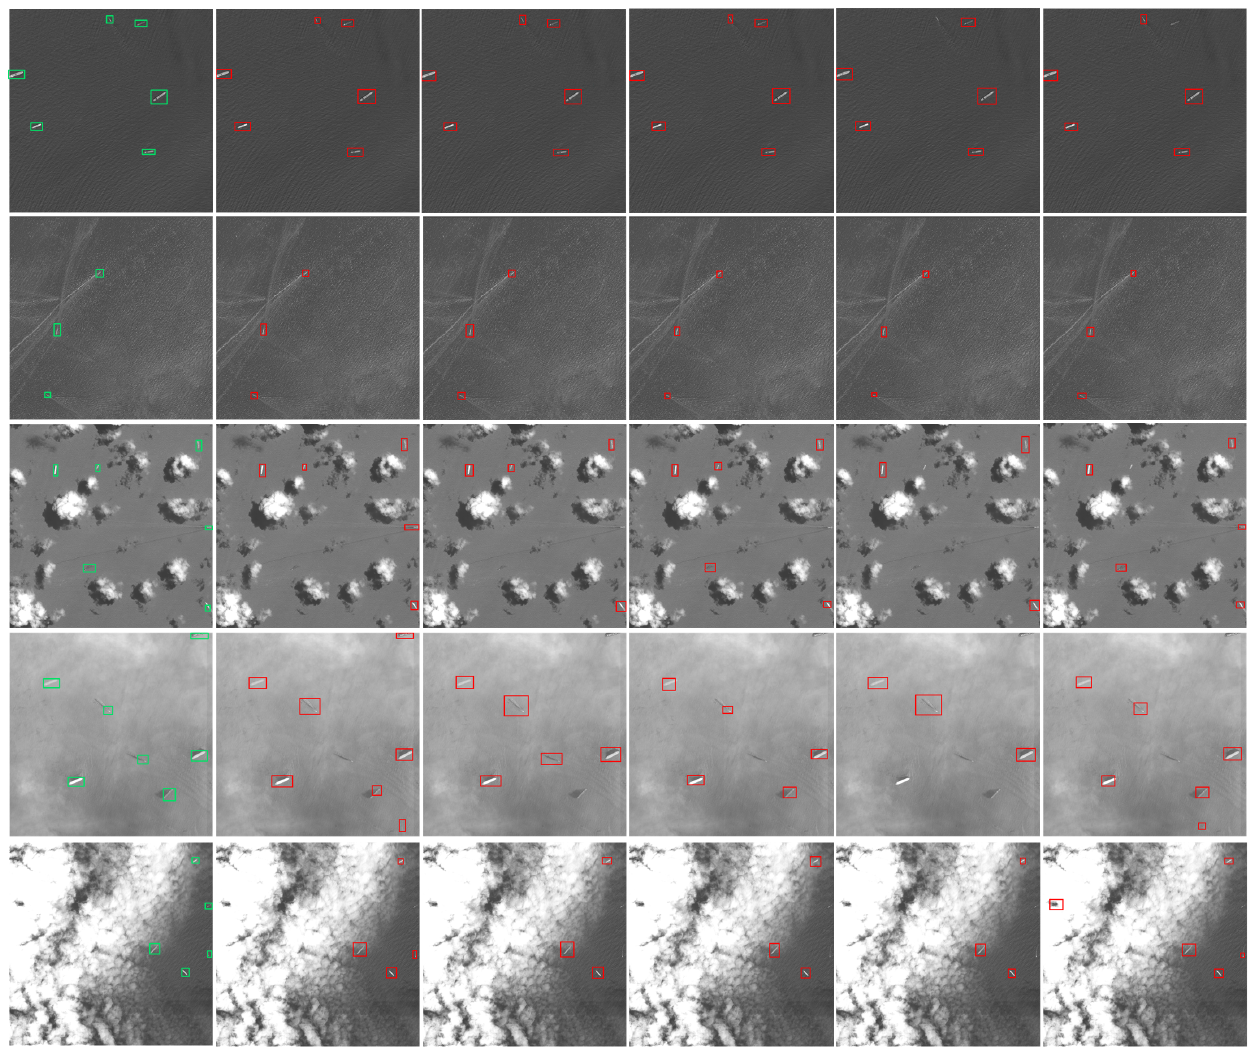
Figure 10. Detection maps for the Nan-Hai dataset based on different methods. Among them, each row represents different scenes: cloudless, big waves, scattered clouds, thin clouds, and thick clouds. The first column represents the original image, columns 2–6, represent the results of our method, YOLOv4, Faster RCNN, SSD, and SPPNet, respectively. Furthermore, the green boxes represent the true ship targets; red boxes represent detected result targets. Table 3. Performance results of different methods (P: precision, R: